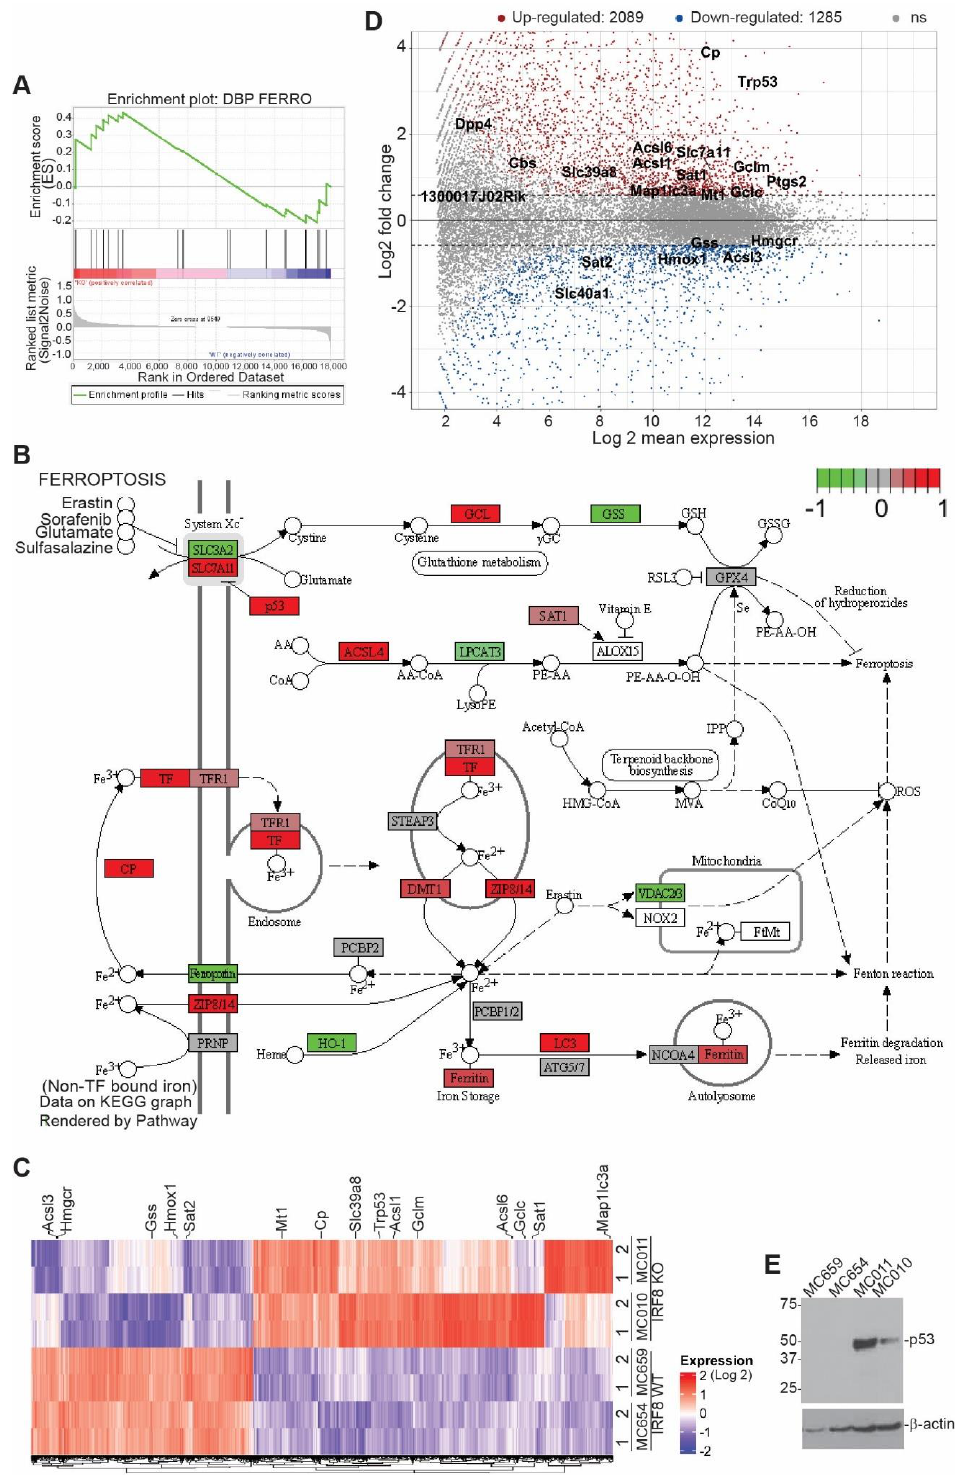
Figure 2. Deletion of Irf8 gene alters the expression of ferroptosis pathway genes. ( A ). RNA sequencing analysis of gene expression of WT and IRF8 KO tumor cell lines. Shown is gene set enrichment analysis of ferroptosis pathway using ranked log2 fold changes. ( B ). KEGG Pathway view of the differentially expressed genes in murine ferroptosis pathway (adjusted p -value < 0.05). Relatively up-regulated genes (log2FC > 1) are shown in red, and relatively down-regulated genes (log2FC < 1) are shown in green. ( C ). RNA sequencing analysis of gene expression in the indicated pairs of IRF8 WT and KO tumor cell lines. Shown is heatmap of genes differentially expressed between WT andIRF8 KO tumor cells. Ferroptosis pathway genes are labelled on the right (1 and